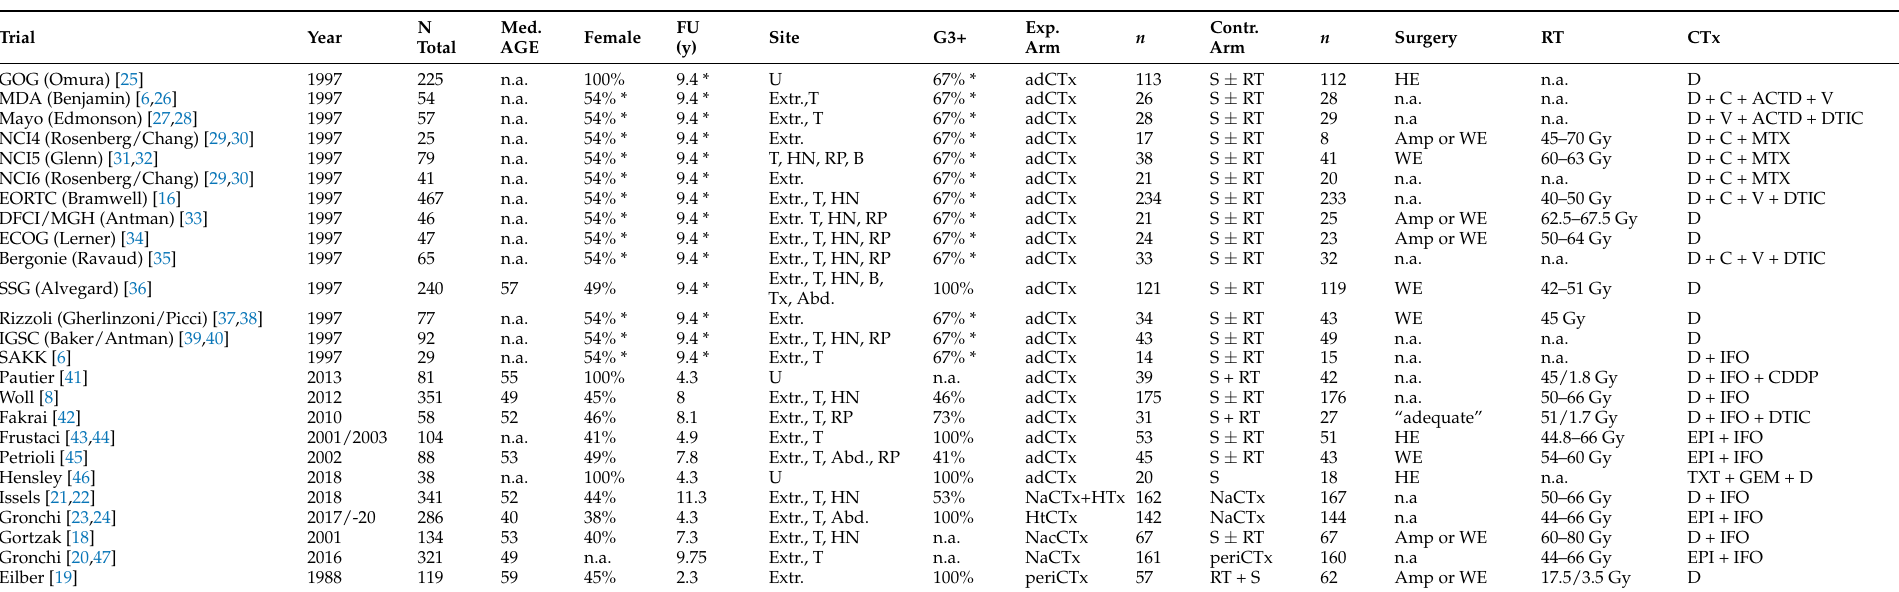
Table 1. Overview of included trials. * = baseline characteristics from SMAC